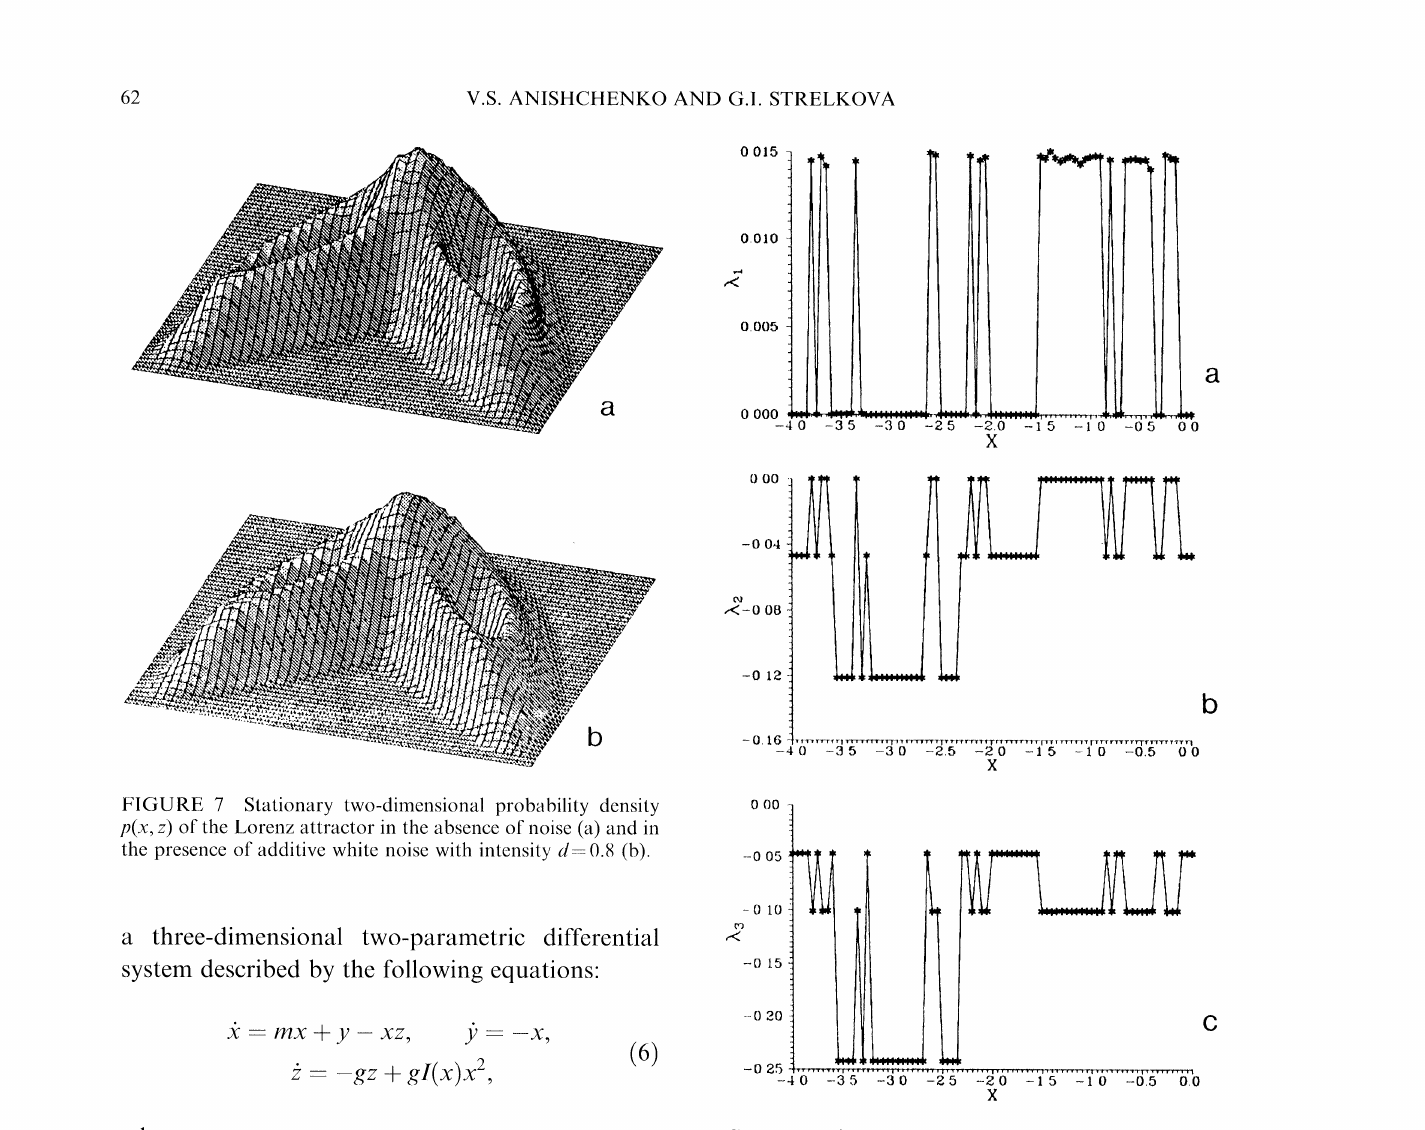
FIGURE 8 The LCE spectrum of system (6) as a function of x coordinate for the parameters m 1.42,